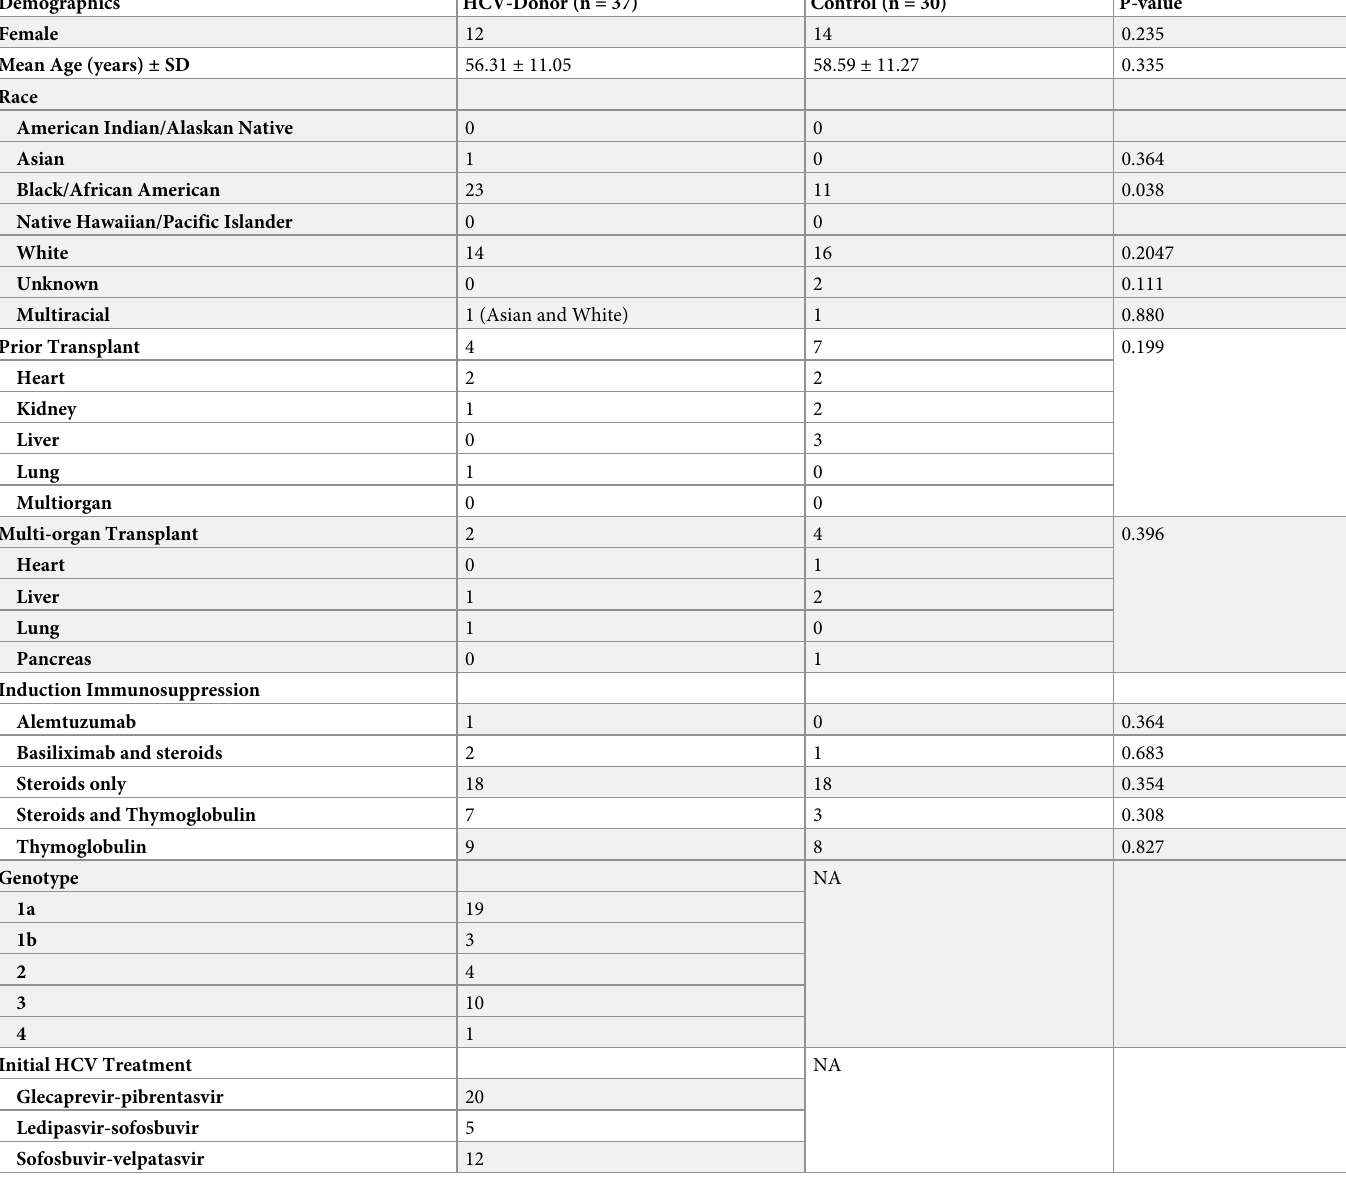
Table 1. Clinical demographics of all enrolled